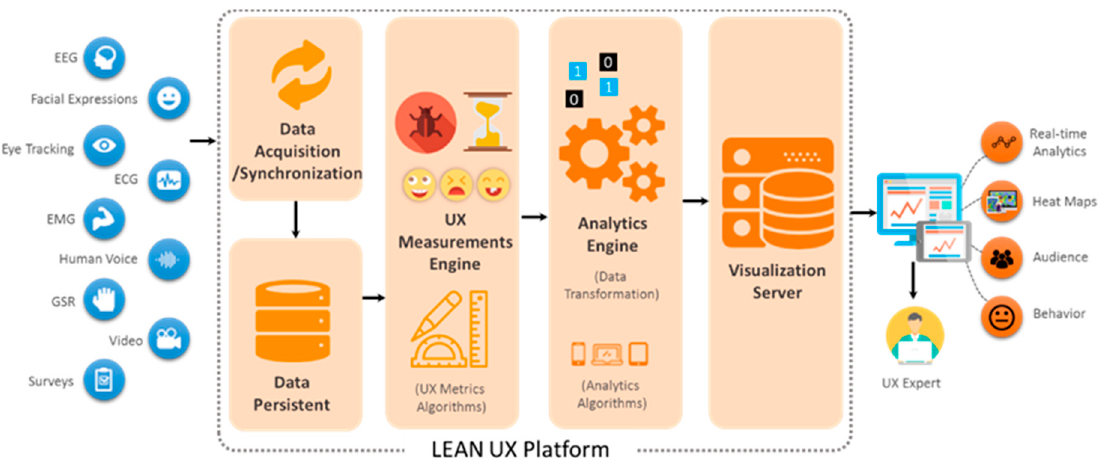
Figure 2. Proposed platform overview.